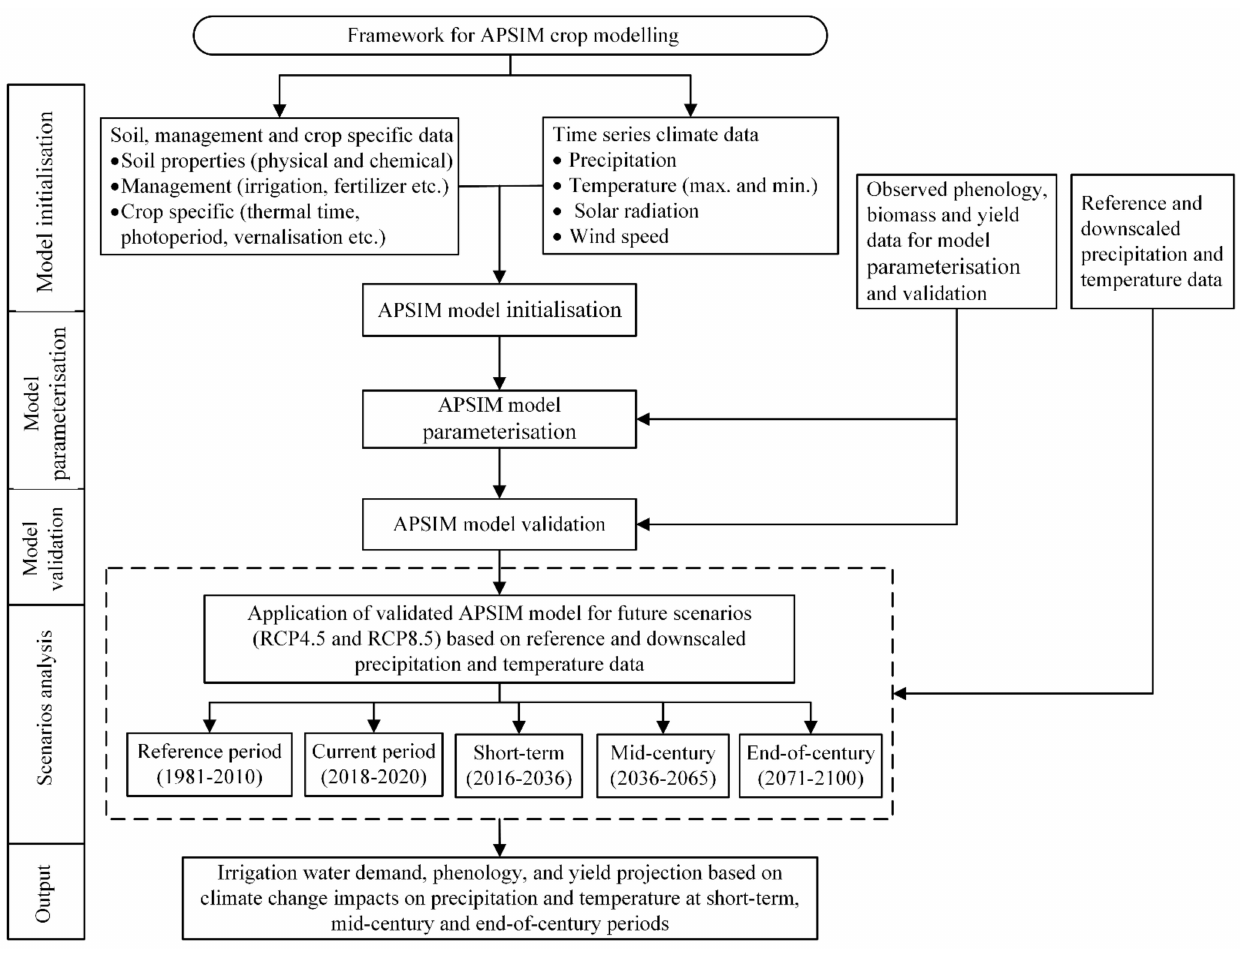
Figure 2. Overview of the study, including soil and climate information used in the modelling, future climate data, model parameterisation, validation, and output. Table 1. Measured soil physical properties: bulk density (BD), air (dry) (AD), lower limit (LL15) (wilting point), drained upper limit (DUL) (field capacity), saturated volumetric water contents (Sat), saturated hydraulic conductivity (Ks), plant available water capacity (PAWC), and soil texture. Values are bulked averages taken from three field plots. The total PAWC was 139